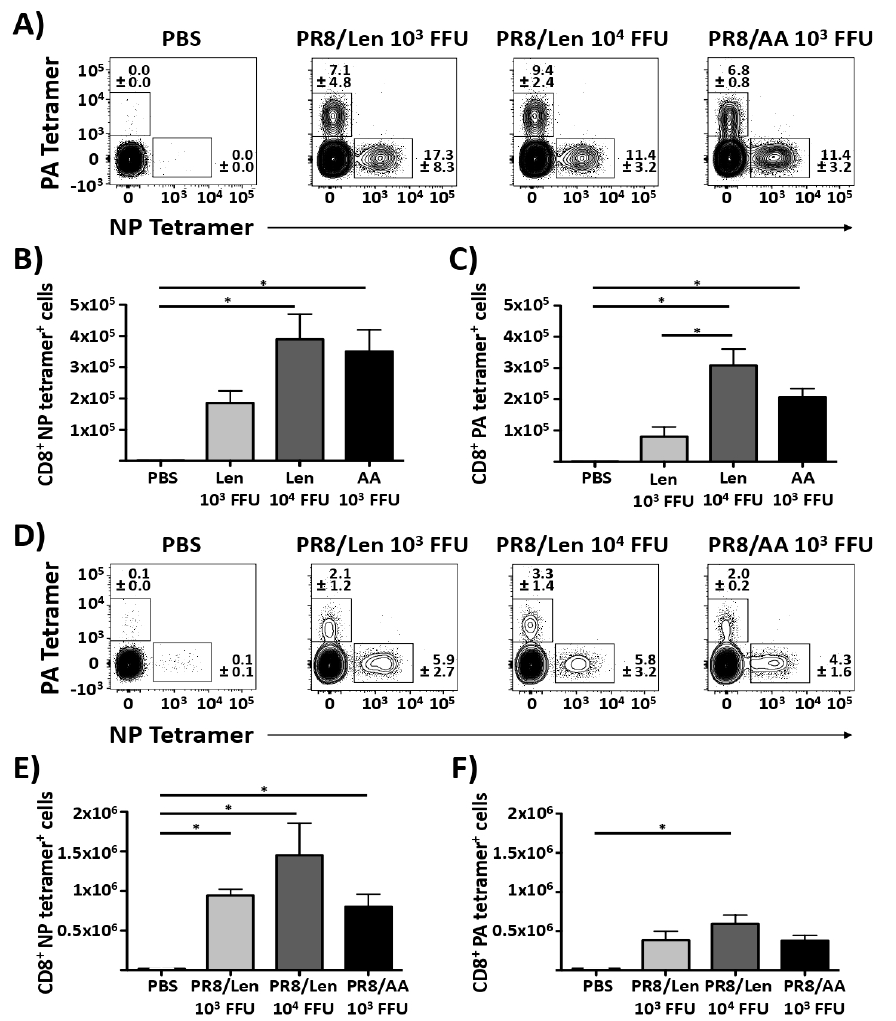
Figure 6. Induction of CD8 T cell responses by PR8 / AA and PR8 / Len viruses: Female six-to-eight-week-old C57BL / 6 mice ( n = 5) were infected (i.n.) with 10 3 and 10 4 FFU of PR8 / Len